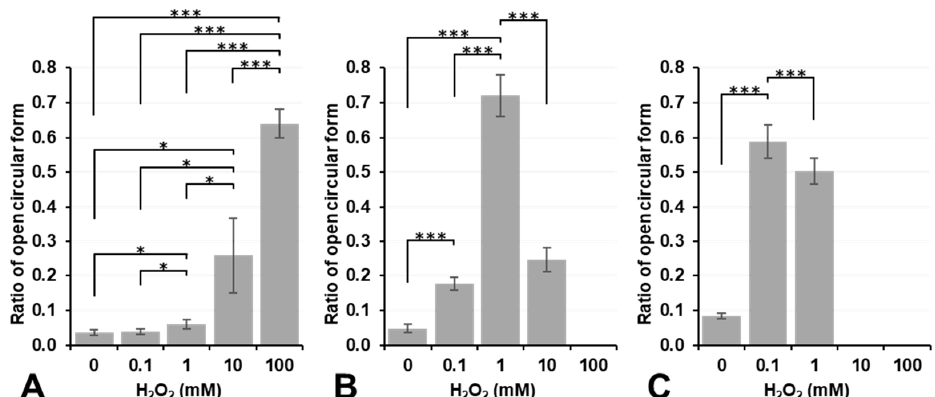
Figure 6. Estimation of plasmid DNA breakage induced by the • OH generated by the decomposition of H 2 O 2 under UV irradiation. Ratio of DNA breakage after UV irradiation at ( A ) 0.0, ( B ) 0.1, and ( C ) 0.5 J/cm 2 with several different concentrations of H 2 O 2 . Columns and error bars indicate the